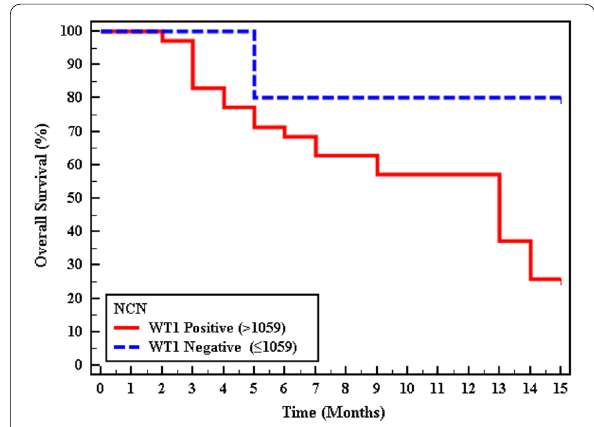
Fig. 3 Kaplan–Meier survival curve for overall survival with WT1 expression ( n =